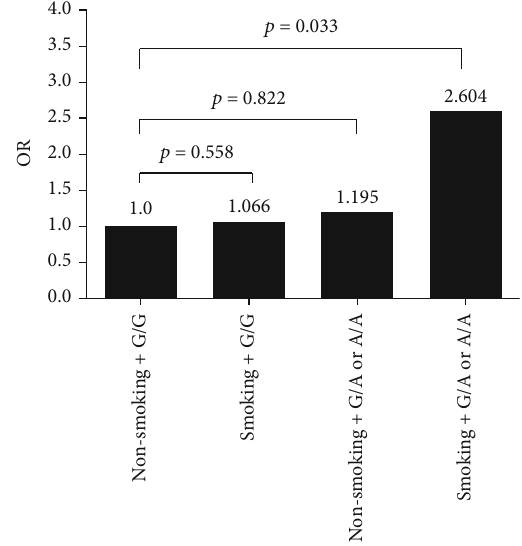
Figure 2: Interaction between smoking and rs3818291 on CHD risk ( P = 0 : 153 ). Logistic regression analysis of the interaction between smoking and rs3818291 on CHD risk. OR ’ and P ’ were determined after adjusting for age, sex, diabetes duration, hypertension, BMI, smoking, and plasma lipid